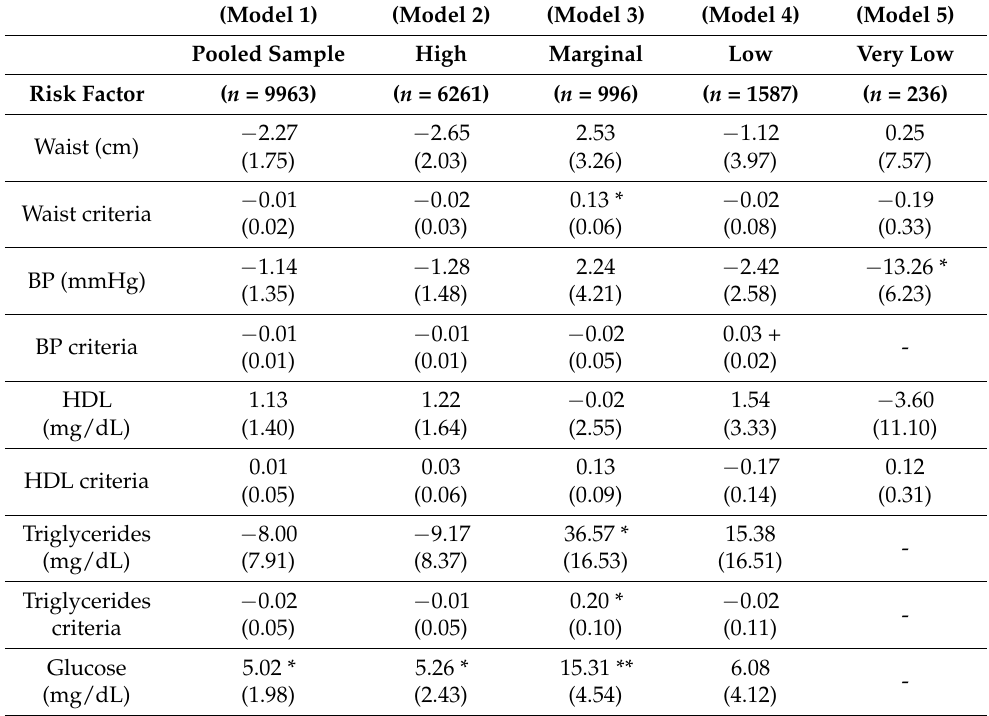
Figure A1. Outcomes across 1.45 PIR Notes: Figure A1 presents the weighted, mean outcome of each cardiometabolic risk indicator across levels of PIR. The red vertical line indicates 1.45 PIR. Table A4. Falsification test—using PIR 1.45.